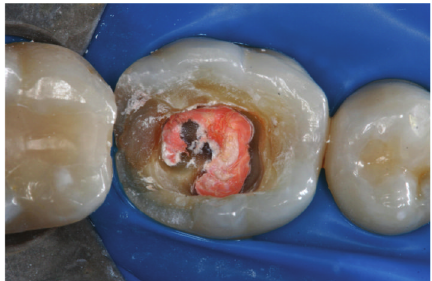
Figure 3: The molar after removal of the provisional restoration.